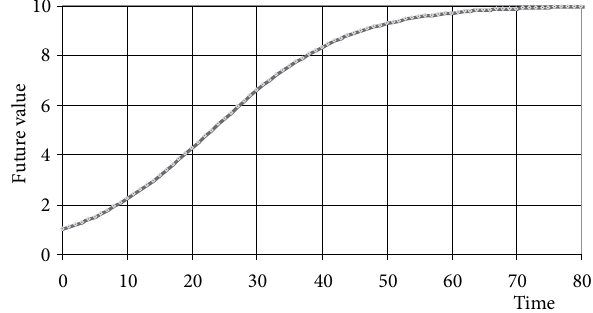
Fig. 4. Logistical future value dependency on time